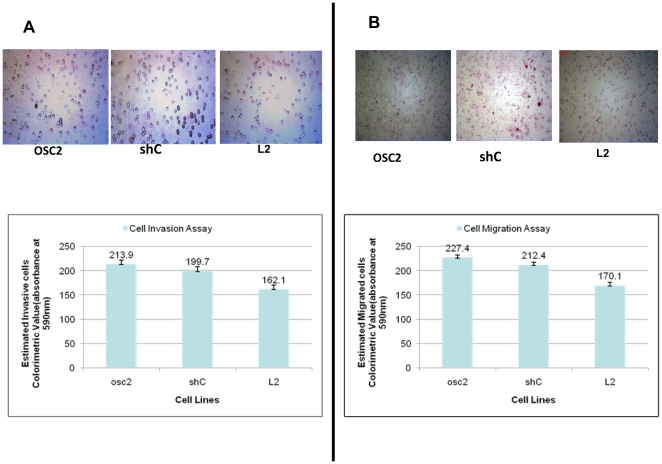

DSPP silencing decreased OSC2 migration and invasion.(A, B) Modified Boyden-Chamber experiment shows that DSPP-silencing in (L2) decreased invasion (A) and migration (B) of OSC2 cells by ∼25%, respectively, compared to shC control and parental OSC2 cells (for each comparison using Dunn methods of multiple comparisons).